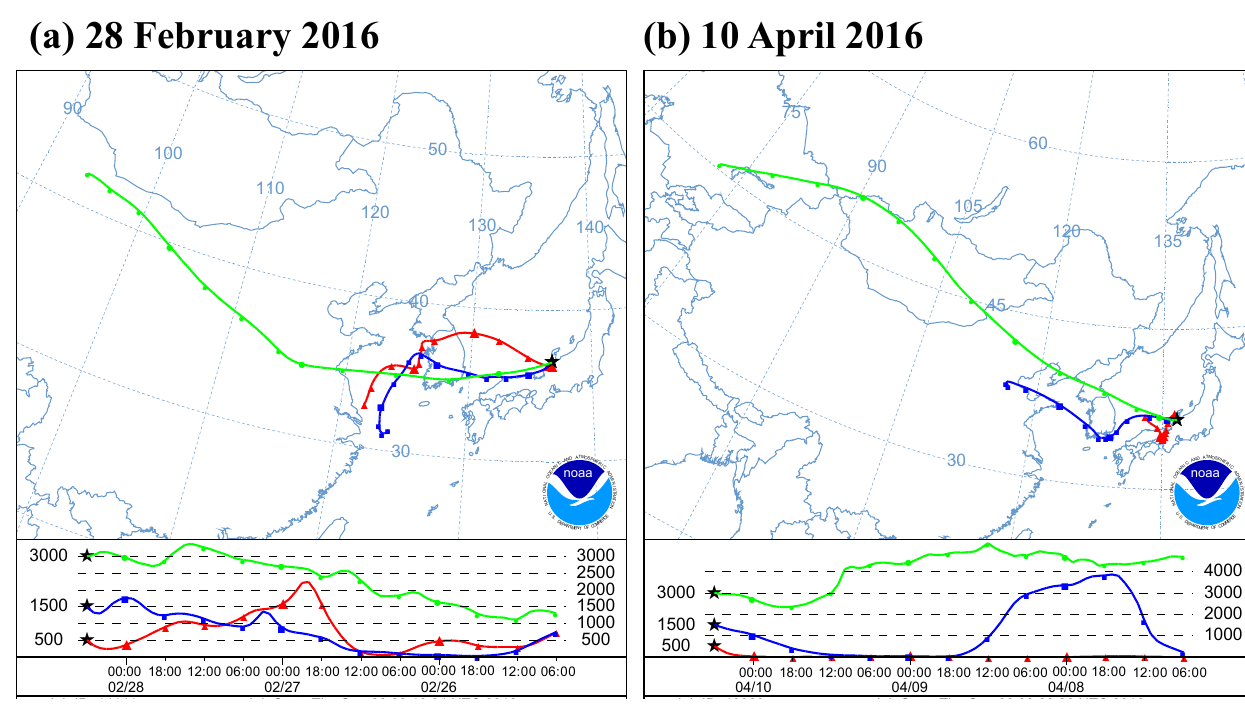
Figure 11. Backward trajectories of air masses that arrived at 3000, 1500, and 500m over the sampling location during the sampling periods on 28 February and 10 April